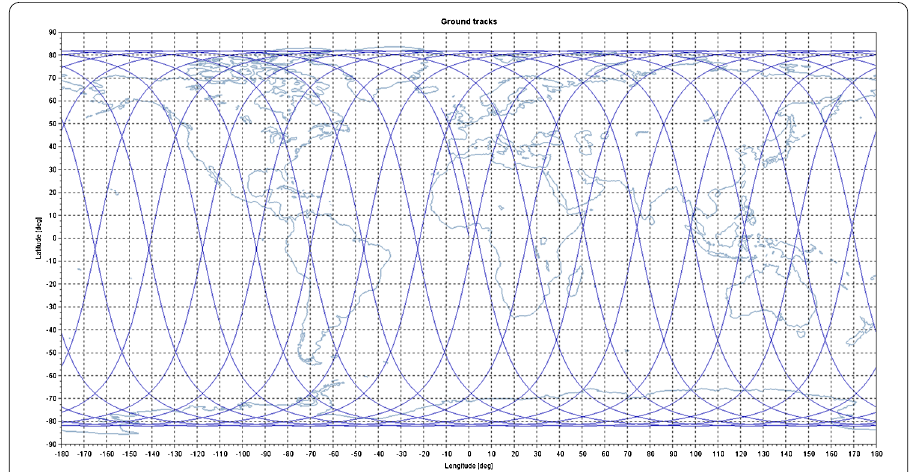
Figure 2 Ground tracks of the simulated SSO at 550 km altitude and with local hour of 22h30 over a period of 1 day. The inclination of the SSO orbit is 98 ◦